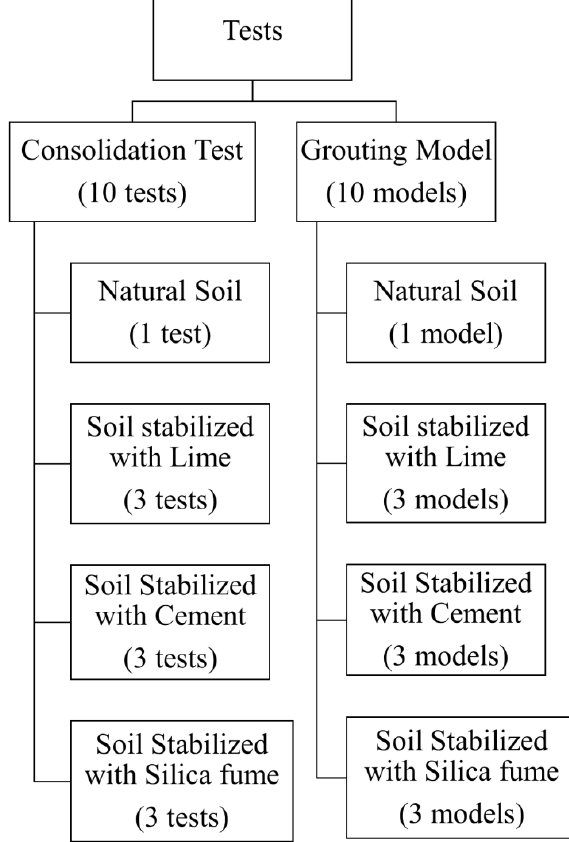
Figure 2. Testing program.